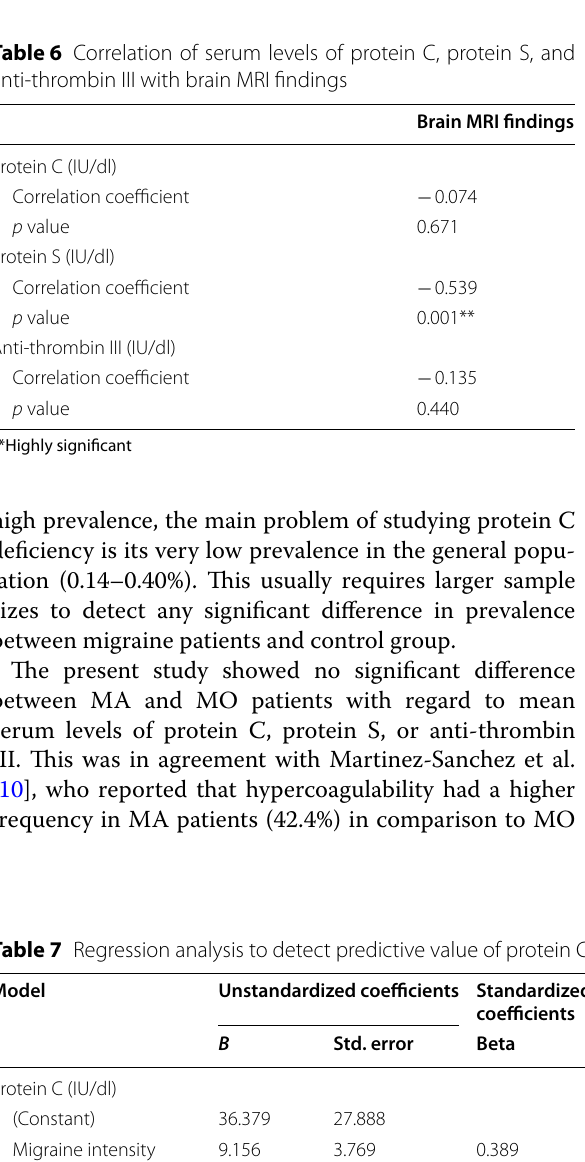
*Significant *Statistically significant at p